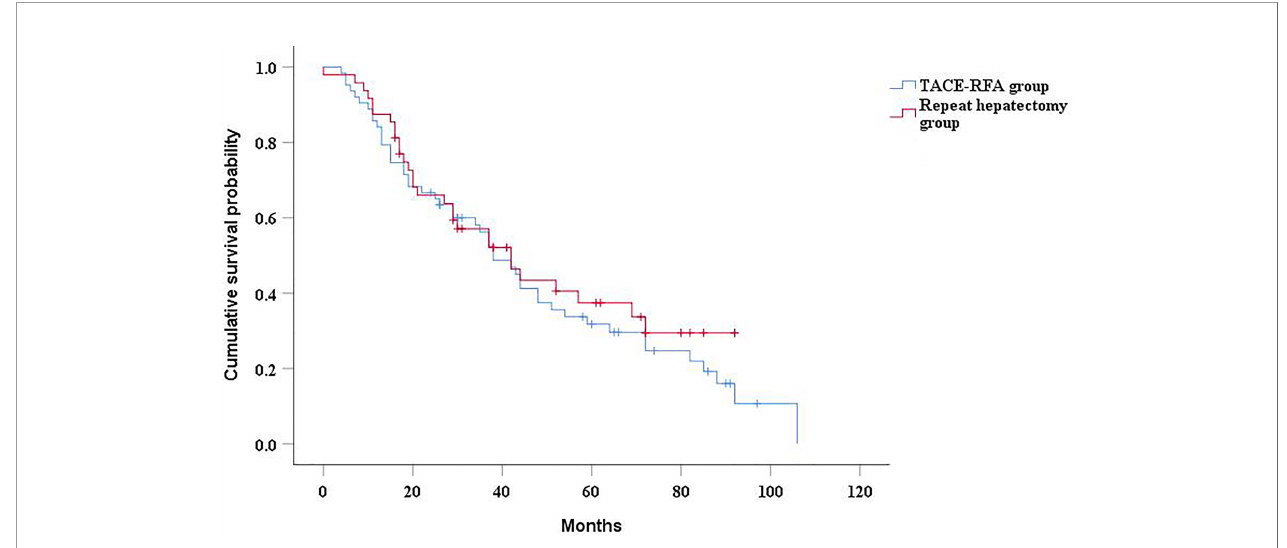
FIGURE 2 | Kaplan-Meier curves of cumulative survival in recurrent HCC patients who received TACE-RFA or repeat